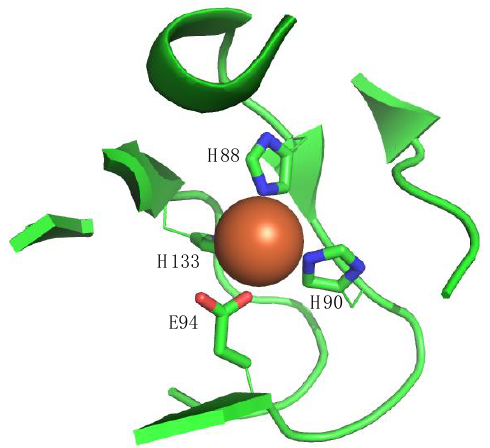
Figure 3. Metal ligation scheme in Hs ARD (PDB entry 4QGN). Protein-based ligands are His88, His90, Glu94 and His133. The metal is reported to be Fe 3+ , although how this was determined is not reported.